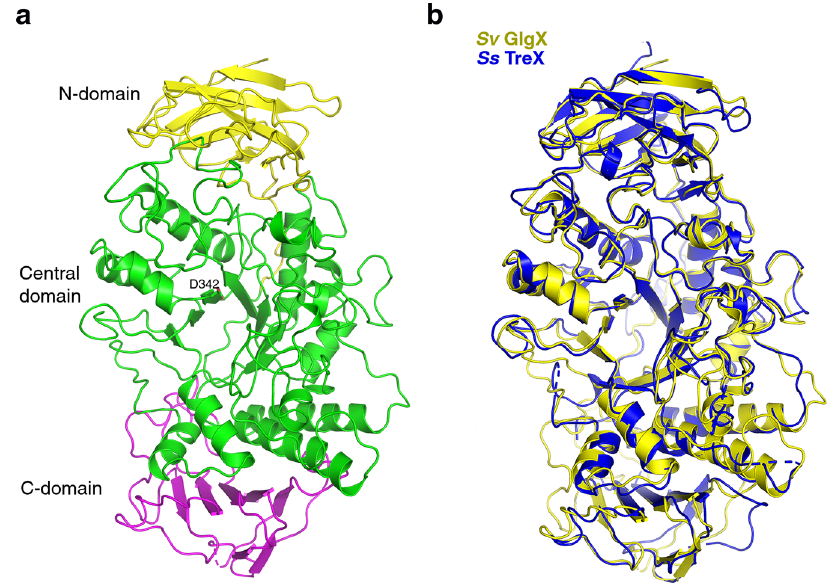
Fig. 4 | Crystal structure of apo S. venezuelae GlgX. a Ribbon diagram of the S. venezuelae GlgX. The domains are labeled and shown in different colors. The N-domain is colored yellow, the Central domain is green and the C-domain is magenta.Also shownassticks and labeled isthe position of the active site residue,